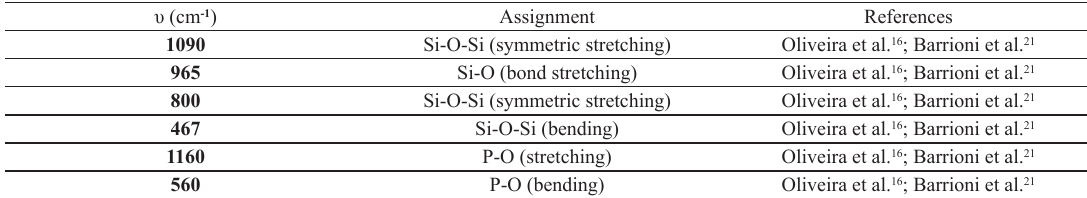
Table 3. Major FTIR vibrational bands associated with bioactive glass.